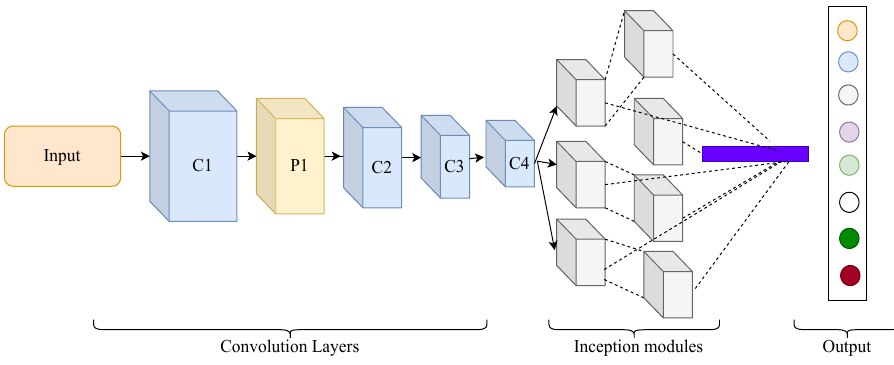
Figure 4. The overview of backbone GoogleNet